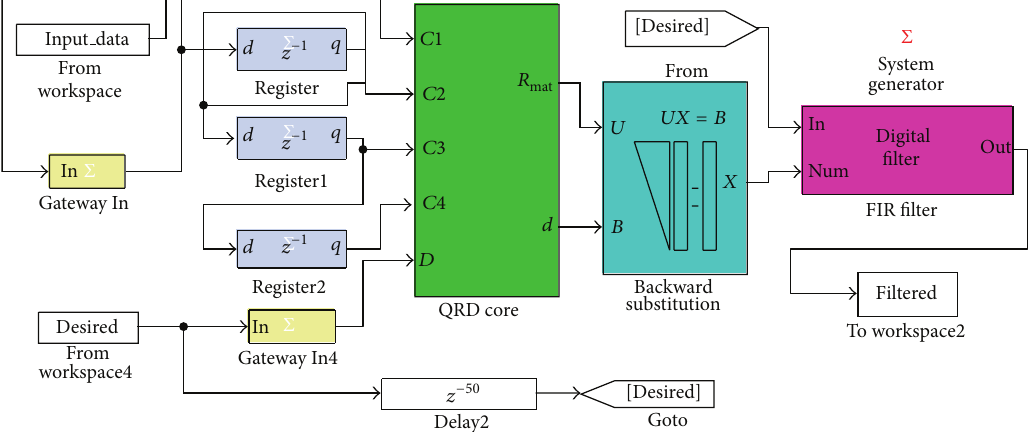
Figure 5: System generator model for a 4-tap QRD-RLS based adaptive equalizer.